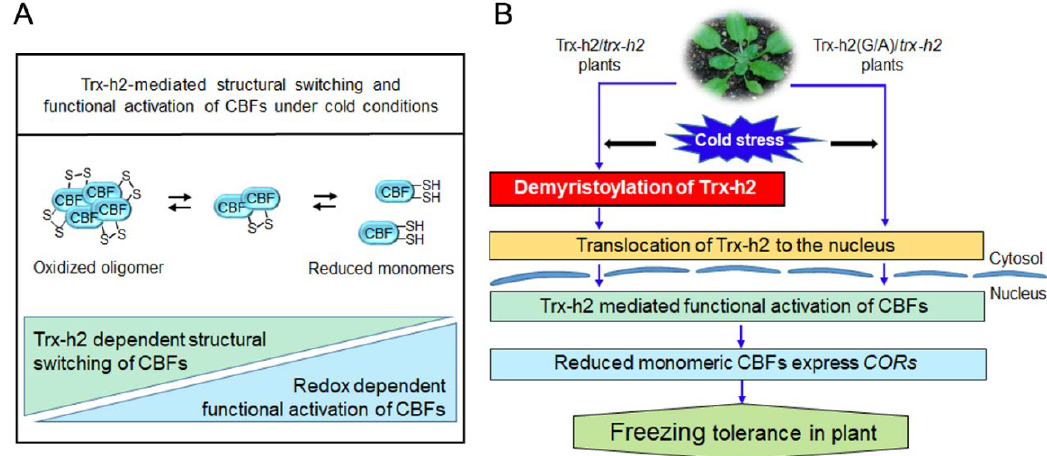
Figure 8. Proposed model demonstrating the significance of the myristyl group attached to the Gly 2 residue of Trx-h2 in the structural switching and activation of CBF1 and, consequently, the regulation of plant freezing tolerance. ( A ) Under cold conditions, Trx-h2 induces the structural switching of CBFs from the oxidized oligomeric state to the reduced monomeric state. The reduced CBF monomers then bind to COR promoters and activate their gene expression, which enhances plant cold tolerance. ( B ) When plants are exposed to cold stress, the Gly 2 residue of Trx-h2 is cleaved, and the demyristoylated Trx-h2 is translocated to the nucleus, where it interacts with CBFs. In the nucleus, Trx-h2 reduces and activates CBFs to transcribe CORs . Unlike Trx-h2, Trx-h2(G/A) is partially localized at the nucleus at warm temperature, and can rapidly respond to a cold snap. Therefore, under cold conditions, the rate of CBF activation and COR gene expression is faster in Trx-h2(G/A)-YFP OE / trx-h2 plants than in plants expressing Trx-h2 . The rapid and efficient response of Trx-h2(G/A)-YFP OE / trx-h2 plants to cold shock results in enhanced freezing